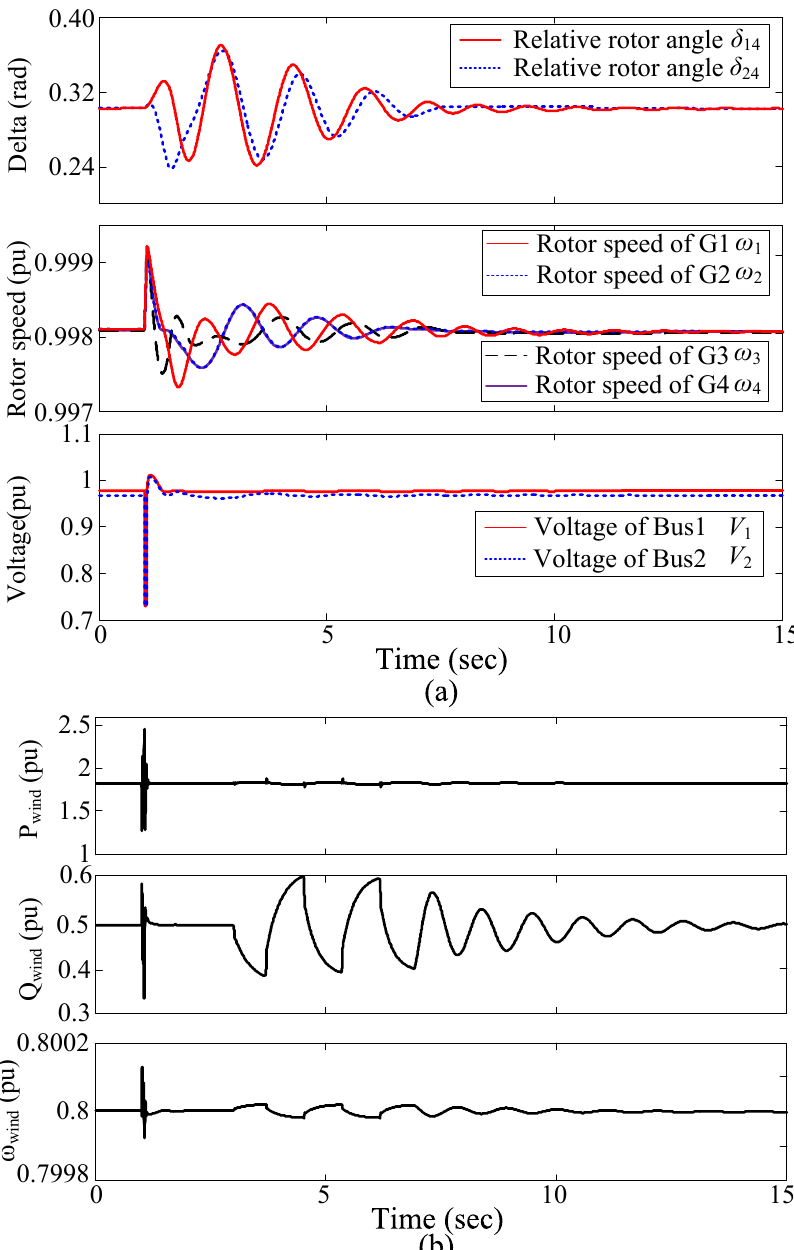
Figure 10. System dynamic performances with damping controller added to voltage feedback control loop. ( a ) Generators dynamics, from top to bottom: δ 14 and δ 24, rotor speeds of the generators, buses voltage; ( b ) DFIG dynamics, from top to bottom: active power of DFIG, reactive power of DFIG, and rotor speed of